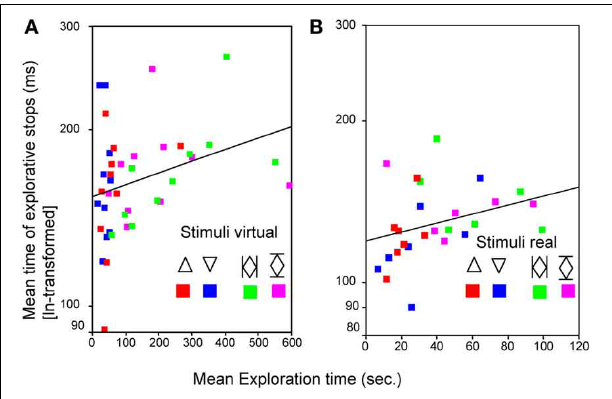
FIGURE 4 | Relationship between mean time of explorative stops (ms) and the mean exploration time (s) for a simple and a complex stimulus in both orientations (1 and 2) for virtual (A) and for real (B) stimuli. Pearson correlation (one tailed) was used.